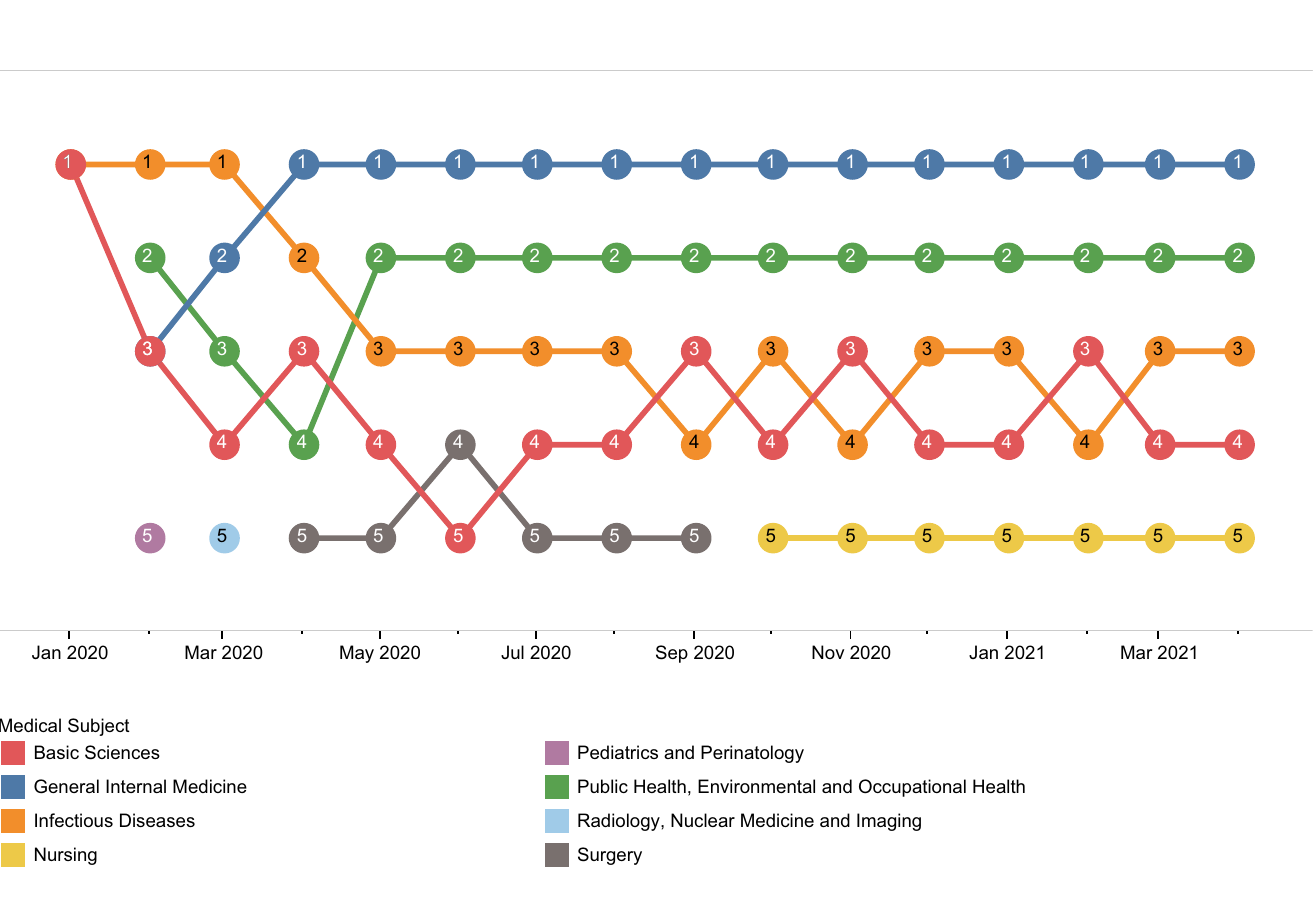
PLOS ONE | https://doi.org/10.1371/journal.pone.0258064 September 30,